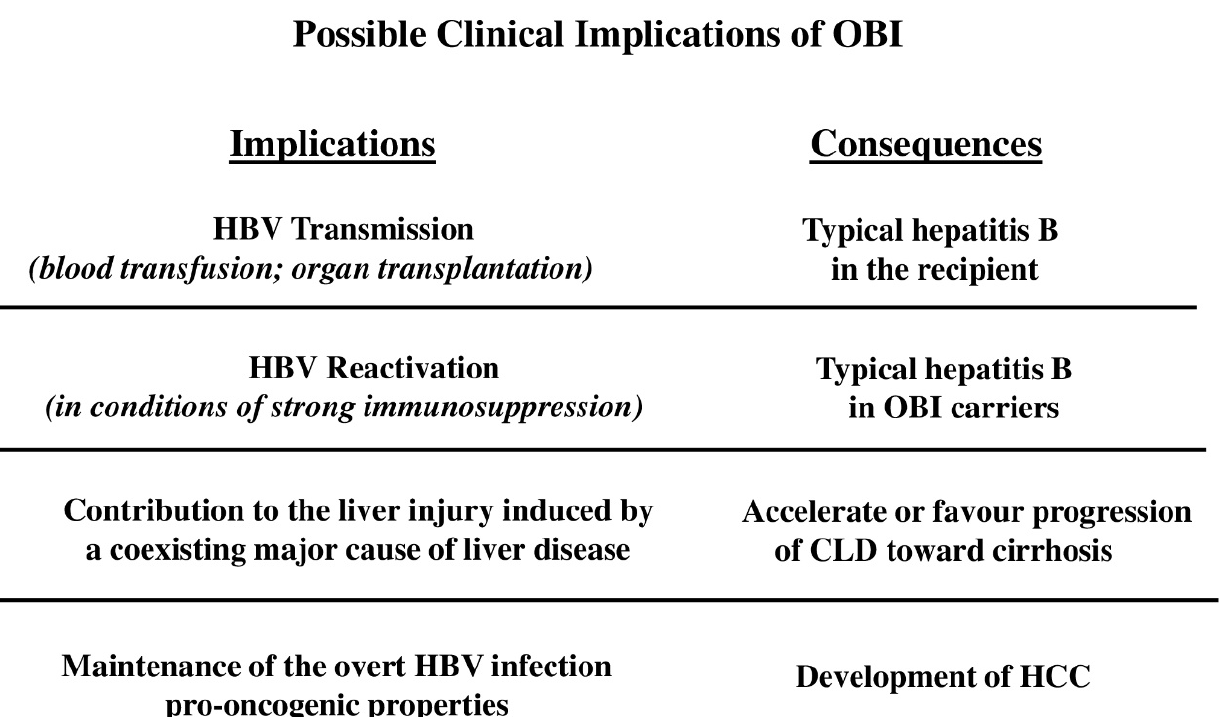
Figure 1. Schematic representation of the clinical impact of occult HBV infection (OBI).